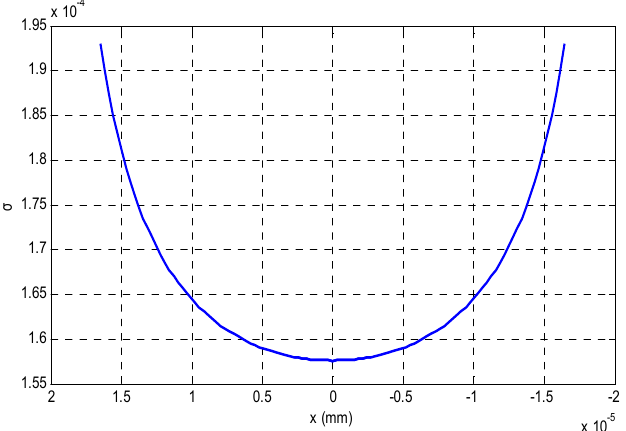
Figure 4. The burring degree of different depth variations.